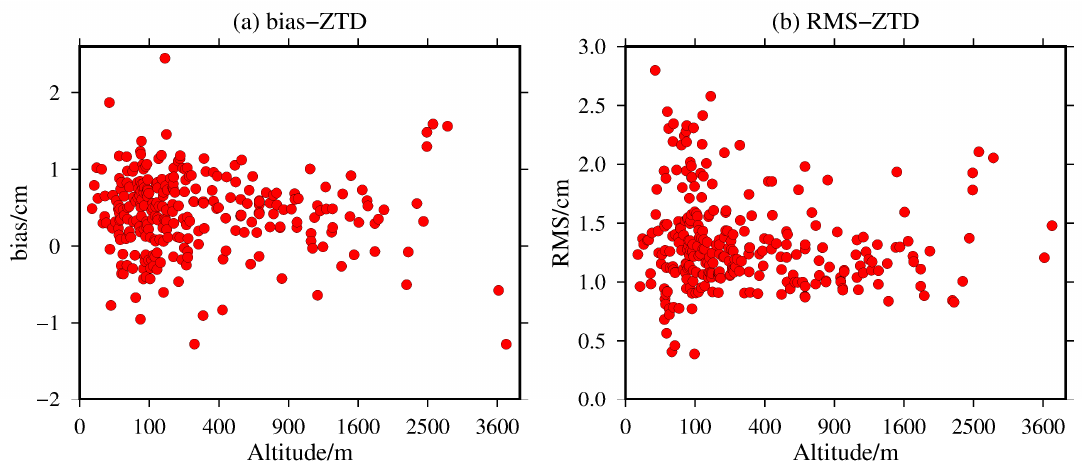
Figure 7. The ( a ) bias and ( b ) RMS of the MERRA-2 ZTD values with respect to altitude variations.